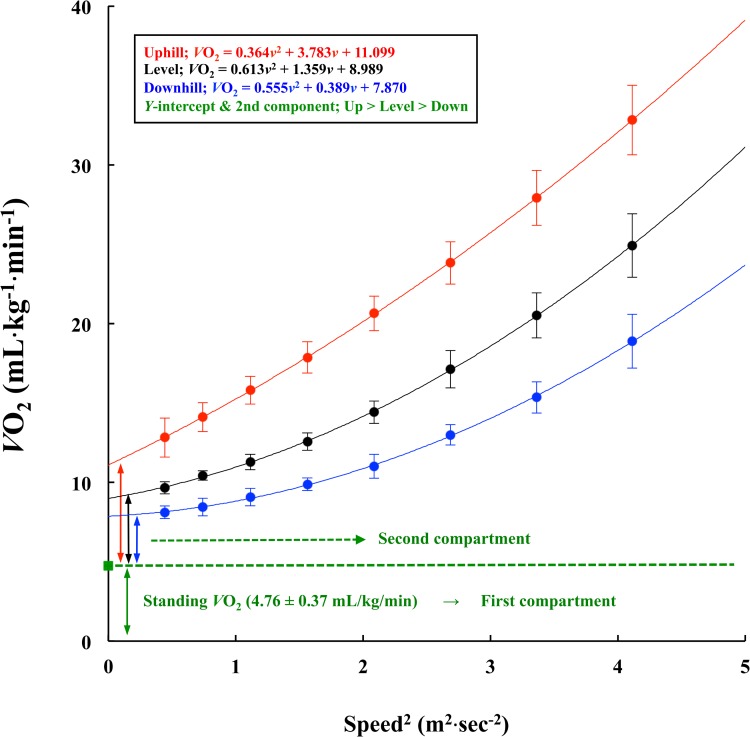
Relationship between VO2 per body mass and square speed at different gradients.The standing VO2 is regarded as the first compartment and a finite difference between y-intercept (coefficient C of Eq 6) and standing VO2 is regarded as the second compartment. Values are mean ± SD.